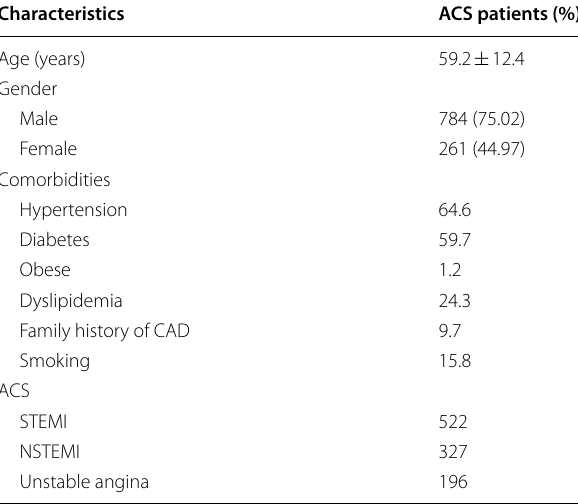
Table 1 Baseline characteristics of patients admitted with acute coronary syndrome